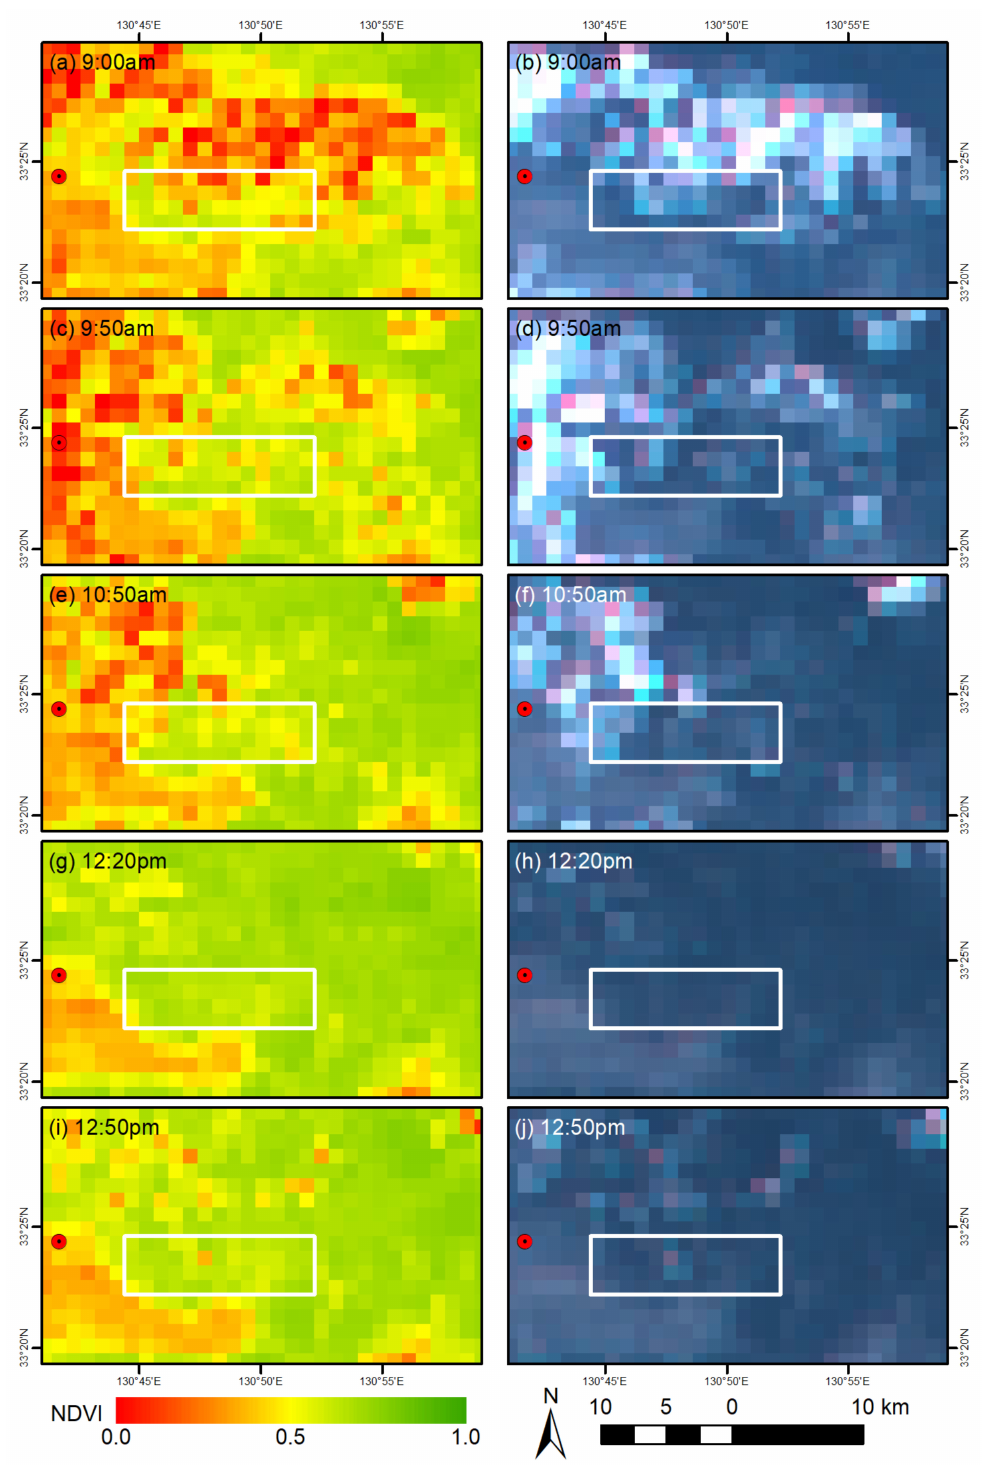
Figure 8. AHI NDVI and natural-color composite image pairs at select observation times for 13 July 2017: ( a ) NDVI and ( b ) color composite at 9:00 a.m. JST; ( c ) NDVI and ( d ) color composite at 9:50 a.m. JST; ( e ) NDVI and ( f ) color composite at 10:50 a.m. JST; ( g ) NDVI and ( h ) color composite at 12:20 a.m. JST; and ( i ) NDVI and ( j ) color composite at 12:50 p.m. JST. The white line boxes represent the region used for the correlative analysis (see Section 3.1 and Figure 6). The map was created with ArcGIS